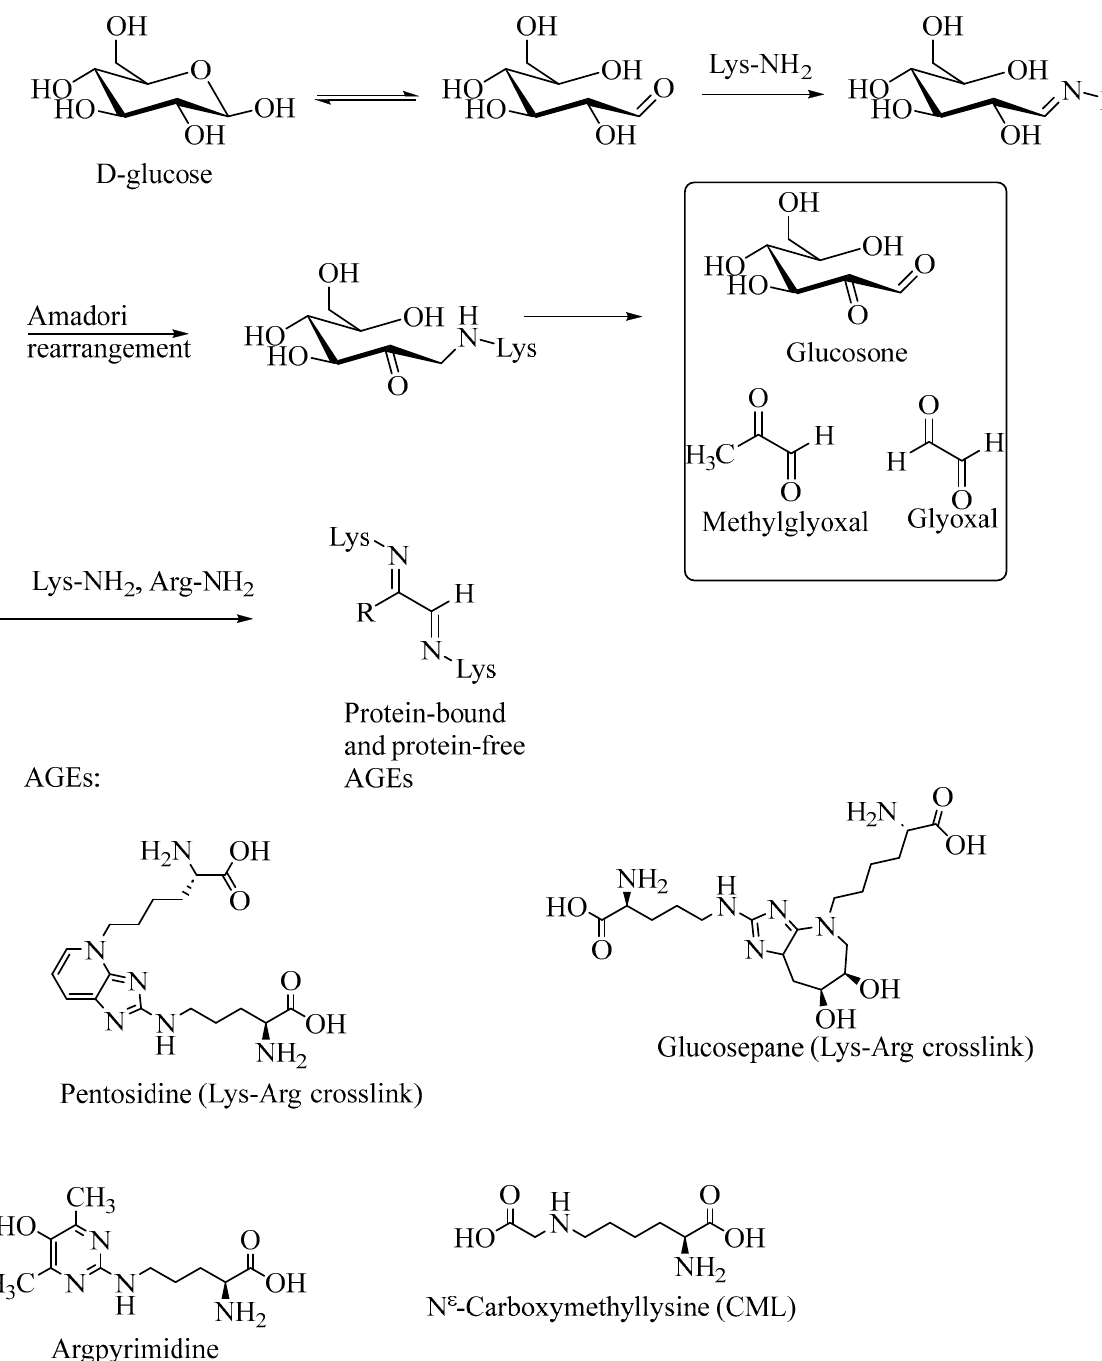
Figure 1. Nonenzymatic glycation of protein amino groups with reducing sugars to form the advanced glycation endproducts (AGEs).